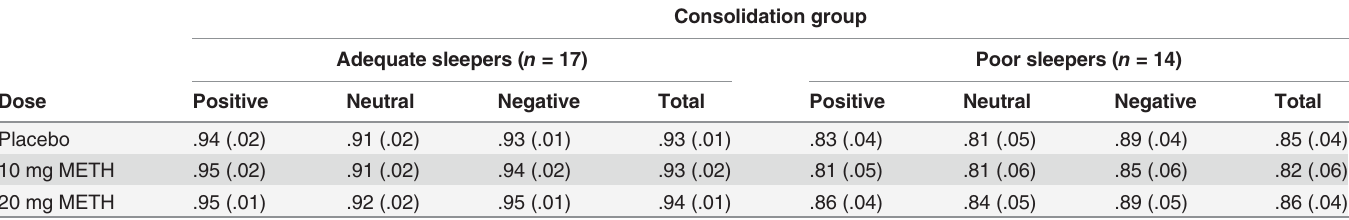
Table 3. Effects of METH on memory accuracy for each valence category and for all categories combined (Total) among adequate and poor sleepers in the consolidation group.